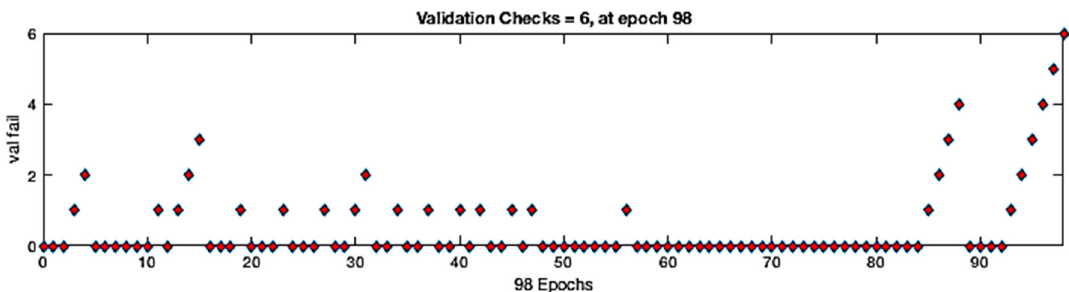
Figure 6. Training validation checks of proposed MLANN.